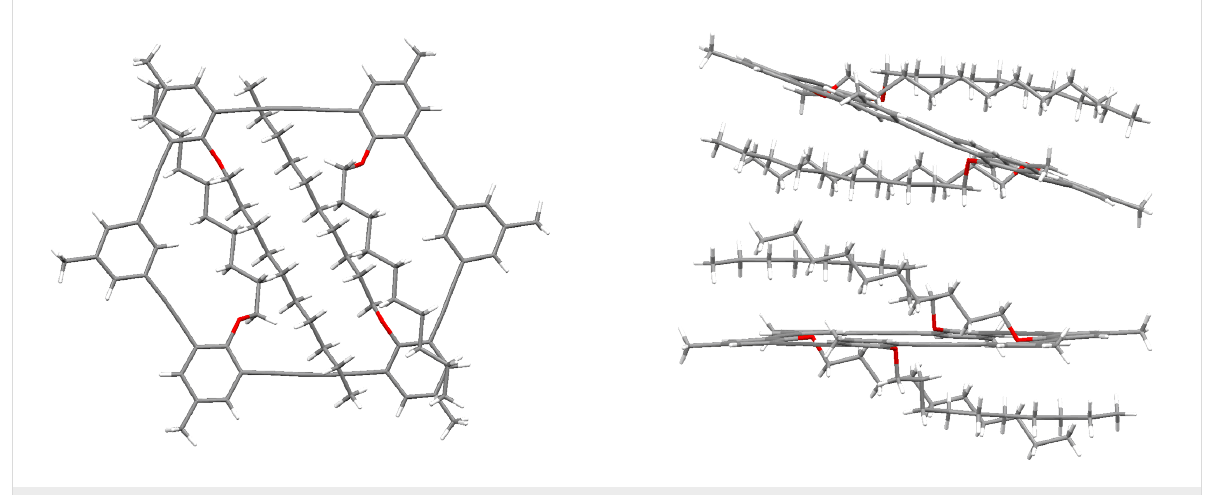
Figure 2: Single crystal X-ray structure of 9a (solvent not shown): a) Top view; b) Side view of two molecules of 9a in the crystal.